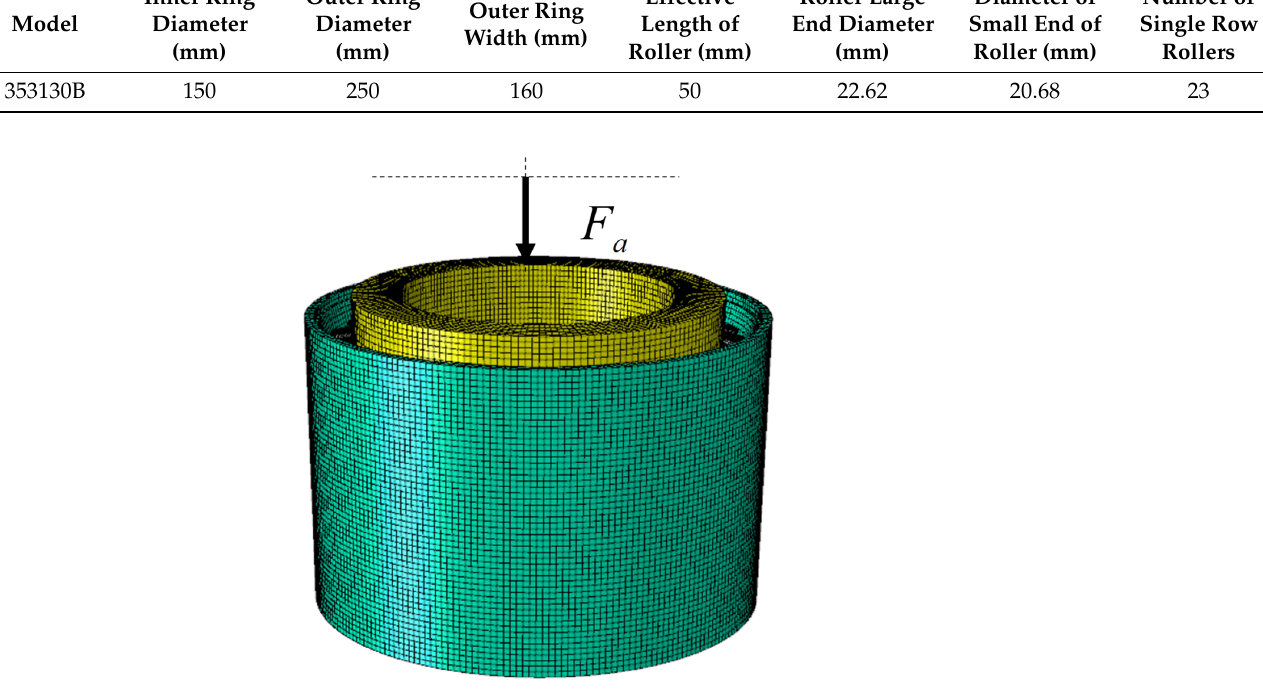
Figure 5. Finite element model. Table 1. Structural parameters of railway bearing 353130B.